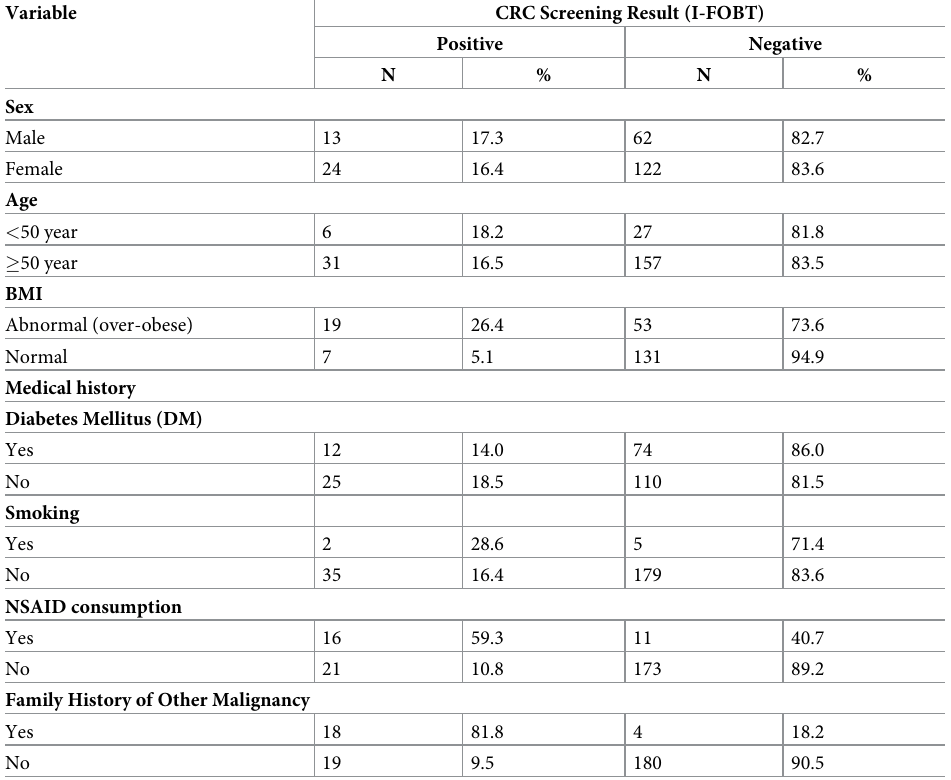
Table 3. Positive I-FOBT results.